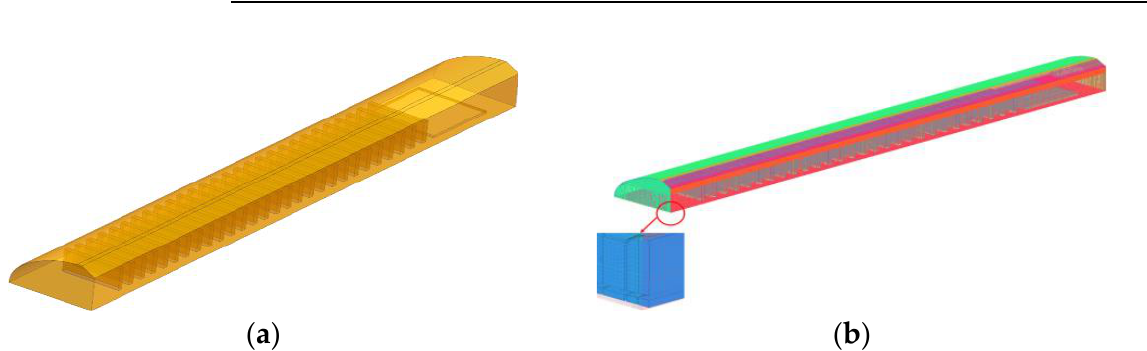
Figure 4. Greenhouse model. ( a ) Three-dimensional model. ( b ) Structured grids. Table 2. Basic parameters and boundary condition settings. In this paper, CFD calculations, the spatial discretizations of the gradient, pressure, momentum, turbulent kinetic energy, turbulent dissipation rate, energy, and discrete Boundary Condi- ordinates are least-squares-call-based, second-order, second-order upwind, first-order Parameters upwind, first-order upwind, second-order upwind, and first-order upwind, respectively. The scheme of the algorithm is SIMPLEC, and the skewness correction is zero. In addition, the residuals of continuity, x-velocity, y-velocity, z-velocity, energy, k, epsilon, and DO intensity are 10 − 3 , 10 − 3 , 10 − 3 , 10 − 3 , 10 − 6 , 10 − 3 , 10 − 3 , and 10 − 6 ,